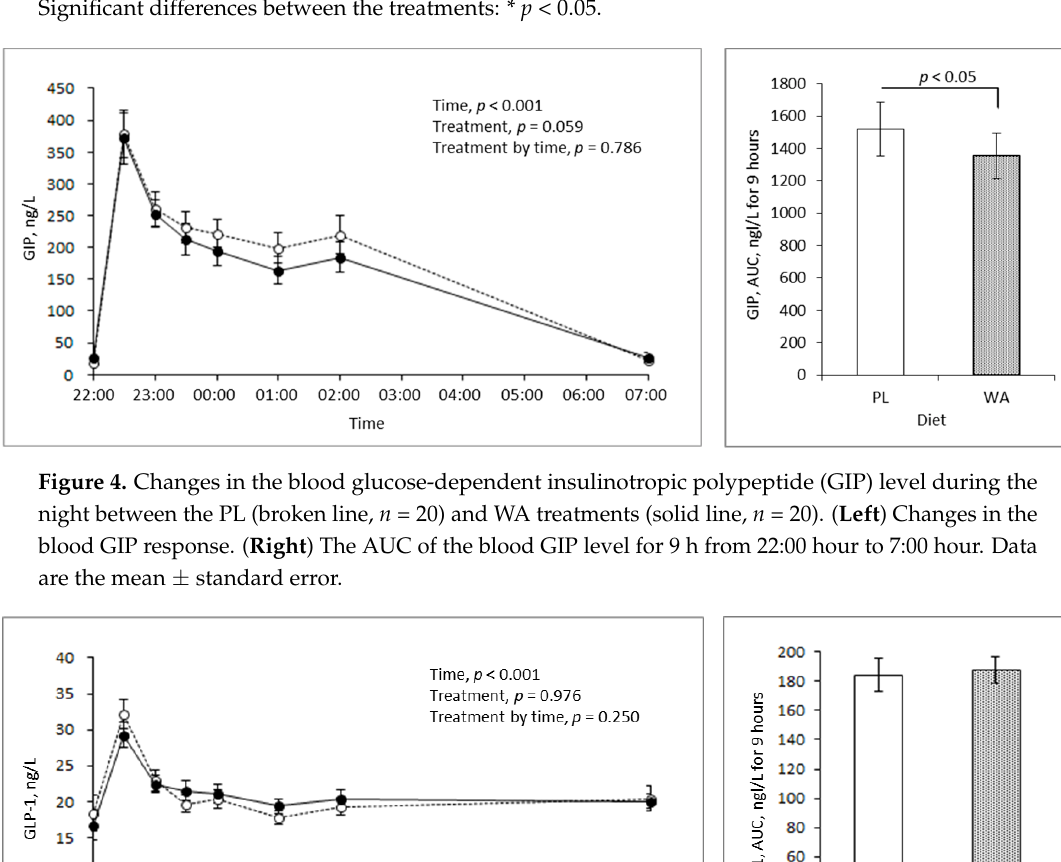
Figure 4. Changes in the blood glucose-dependent insulinotropic polypeptide (GIP) level during the night between the PL (broken line, n = 20) and WA treatments (solid line, n = 20). ( Left ) Changes in the blood GIP response. ( Right ) The AUC of the blood GIP level for 9 hours from 22:00 hour to 7:00 hour. Data are the mean ± standard error.